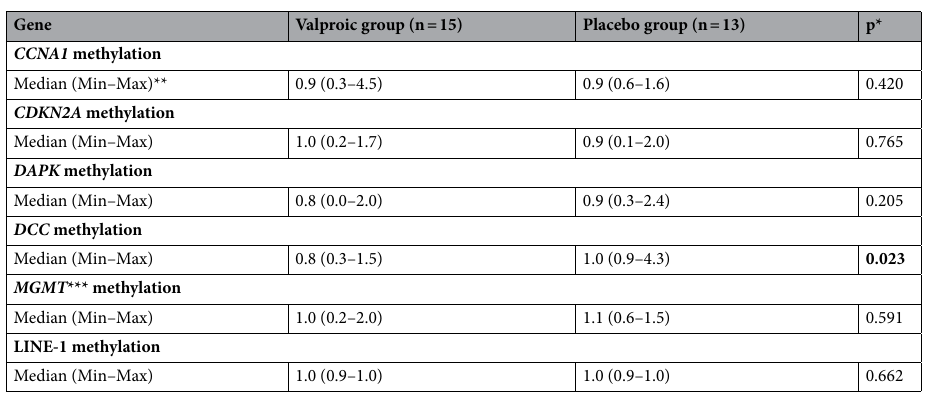
Table 4. Medians of the methylation ratios of different genes in the posttreatment oral rinse (T1) in relation to the pretreatment time (T0) between the valproic and placebo groups. *Calculated by the Mann–Whitney test. p-value < 0.05 is presented in bold. **Min–Max = minimum–maximum. ***For MGMT dosage, 12 placebo samples were considered, since during one of the time points of one of the participants, it was not possible to evaluate